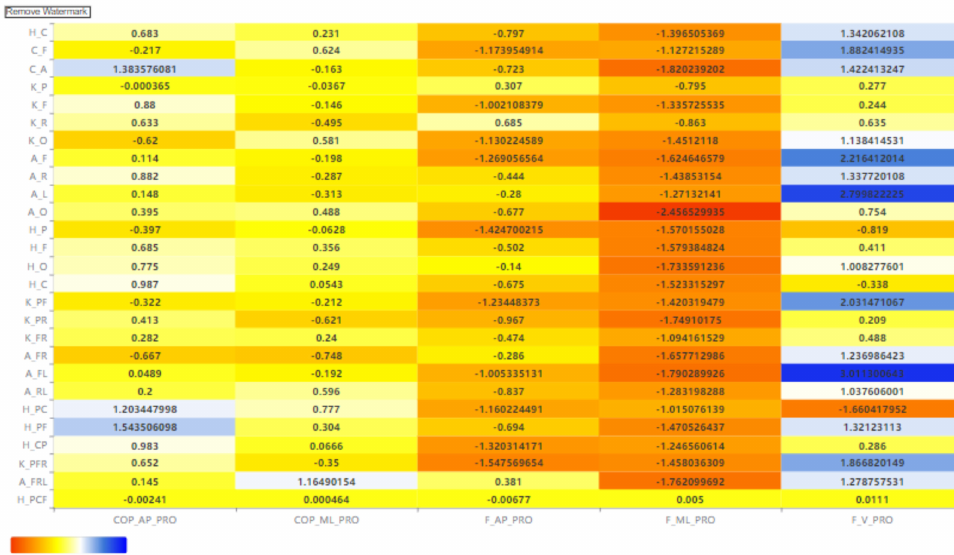
Figure 14. Heatmap depicting the SHAP value of the 5 feature sets. Using this heatmap, it can be inferred that the F_ML_PRO feature set (Medio-lateral GRF) has a mostly negative impact on the prediction, while the feature set F_V_PRO (Vertical GRF) has a mostly positive impact on the prediction across all the